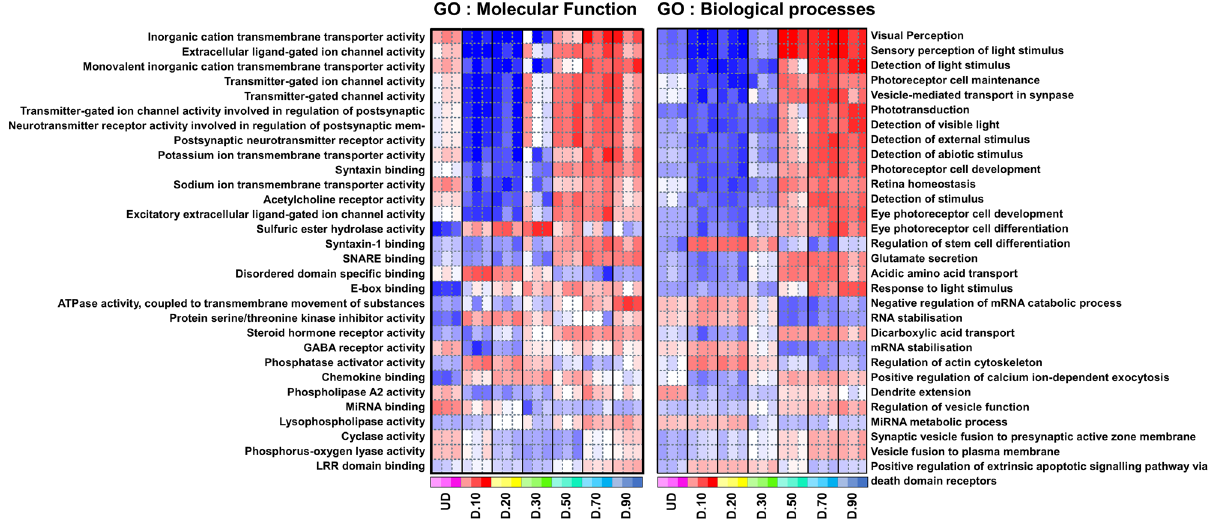
Figure 4. Gene Ontology Analysis of DEGs. Heatmaps illustrates gene ontology evaluation using the parametric gene set enrichment analysis (PGSEA; Furge and Dykema, 2012) in iDEP91, to compare between all sample groups. DEGs were classified into different functional categories according to the GO term enrichment analysis for ( A ) molecular function and ( B ) Biological